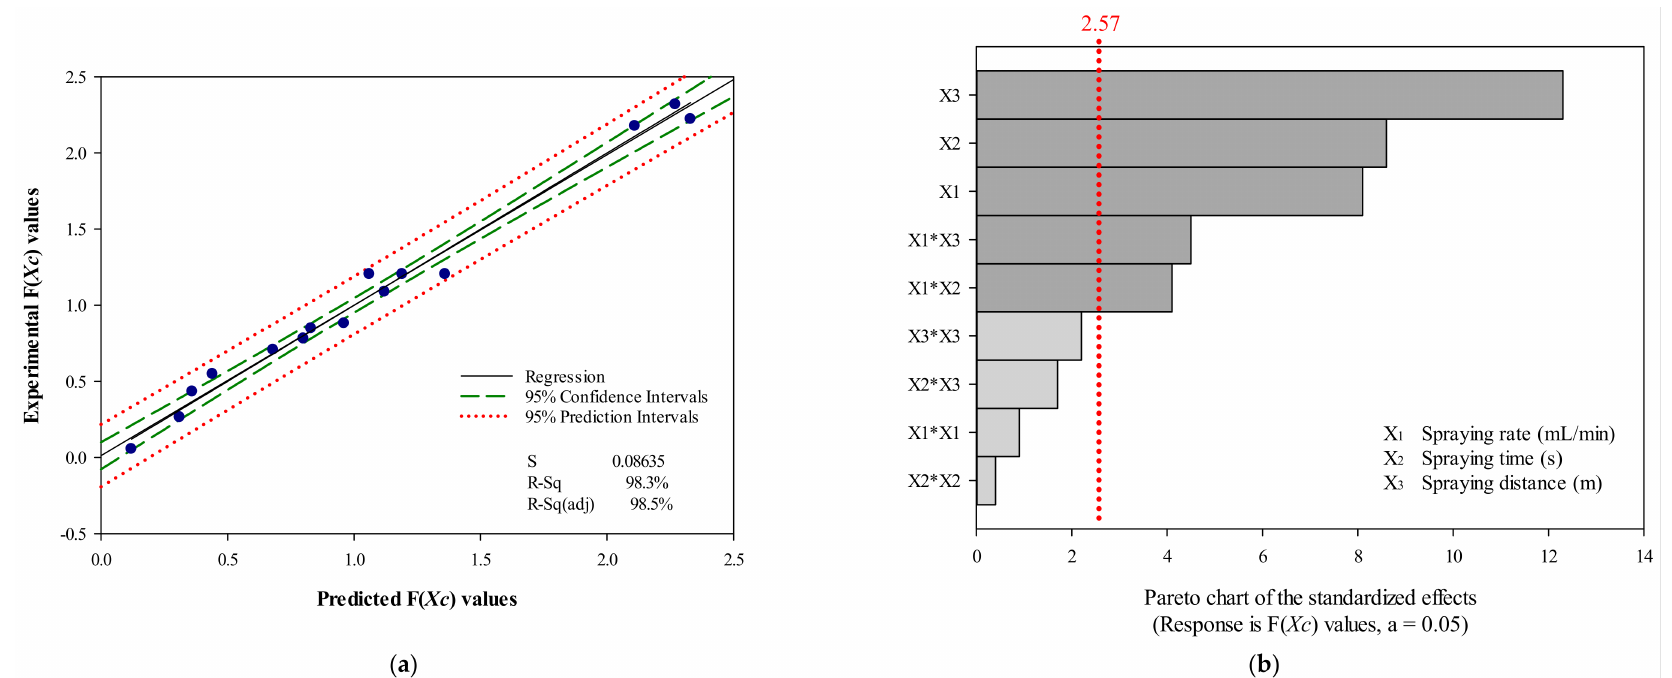
Figure 2. ( a ) Fitted line plot for the predicted and experimental values of the color response value (F( X C )), ( b ) standardized Pareto chart for the color response value (F( X C